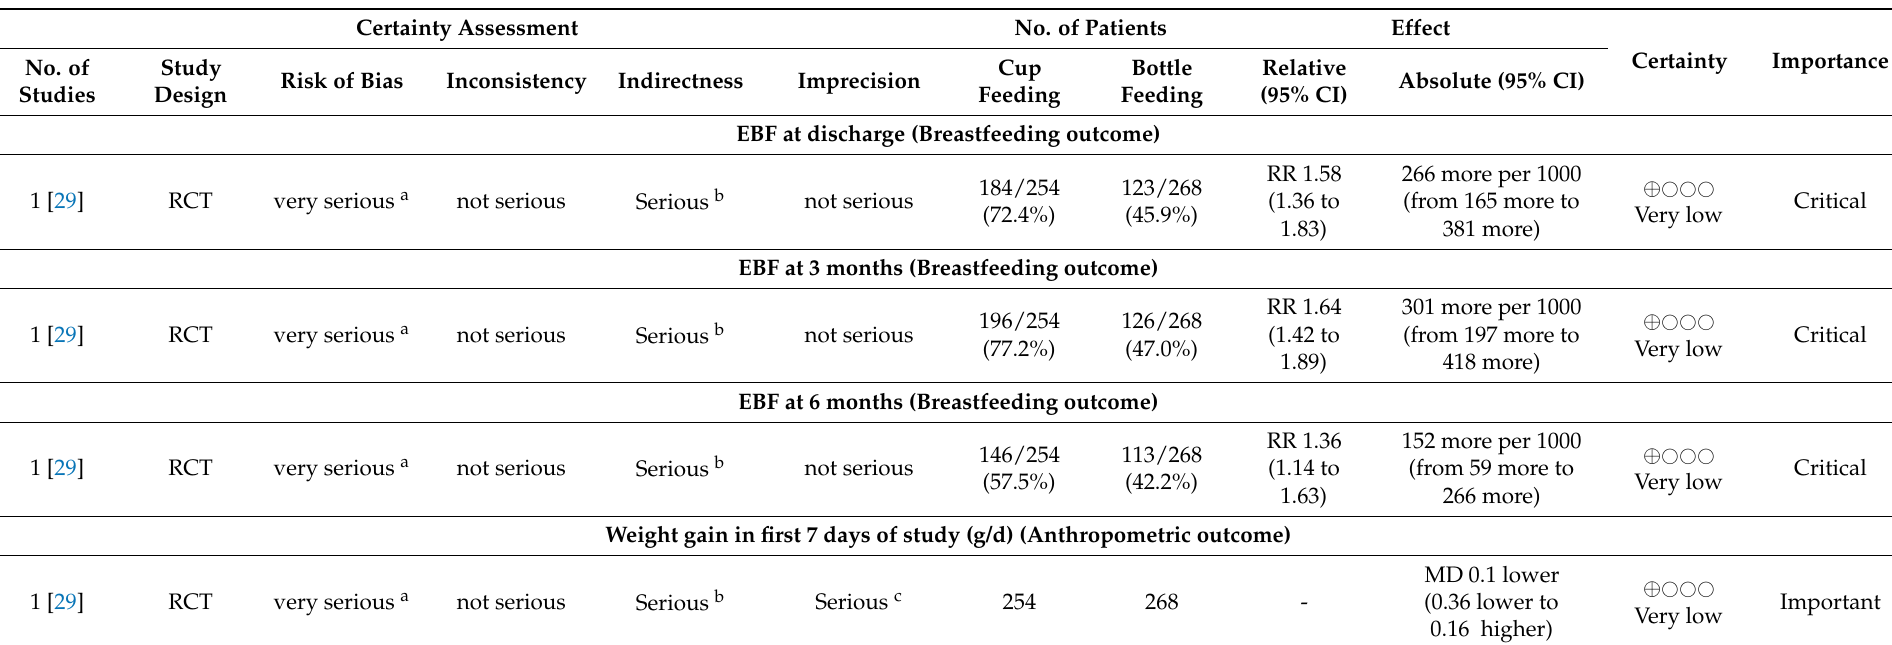
Table 6. GRADE evidence profile: Cup feeding compared to bottle feeding for infants u6m with growth faltering. Certainty Assessment No. of Patients Effect